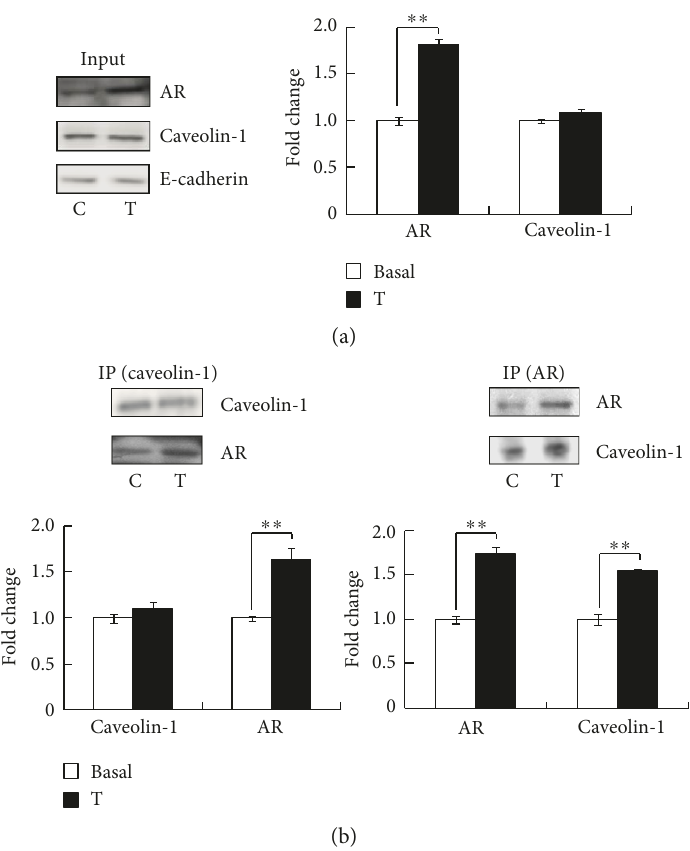
Figure 2: Membrane AR associated with caveolin-1. (a) AR and caveolin-1 translocation in membrane fraction under testosterone treatment in TM4 cells. (b) The fi lm images showed representative Western blot analysis for caveolin-1 and AR in the membrane fraction proteins after immunoprecipitation by the anti-caveolin-1 antibody (left) or anti-AR antibody (right) in TM4 cells treated with 10nM testosterone for 30min. ∗∗ P < 0 01